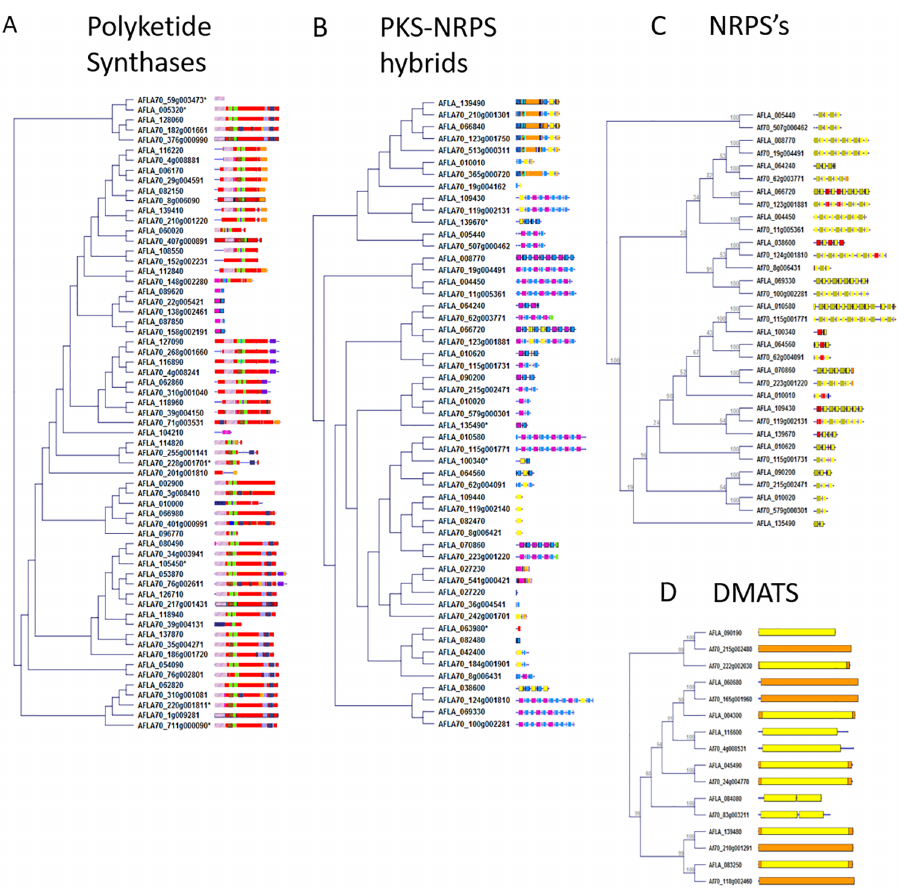
Fig 3. Secondary metabolic gene cluster backbone genes. The “backbone enzymes” of secondary metabolic gene clusters in A . flavus strains AF70 and NRRL 3357 (S- and L-morphotypes, respectively) were compared and clustered according to amino acid sequence similarity. The colored segments indicate domains identified by InterProScan. A) Polyketide synthases (PKSs), B) Polyketide synthase-nonribosomal peptide synthetase hybrids (PKS-NRPSs), C) nonribosomal peptide synthetases (NRPSs), and D) dimethylallyl tryptophan synthases (DMATs).